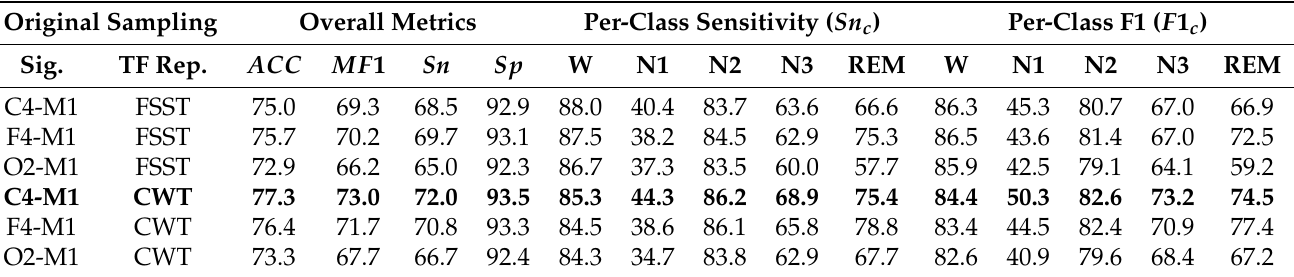
The bold rows in the tables show the best performing scenarios which are further discussed in the